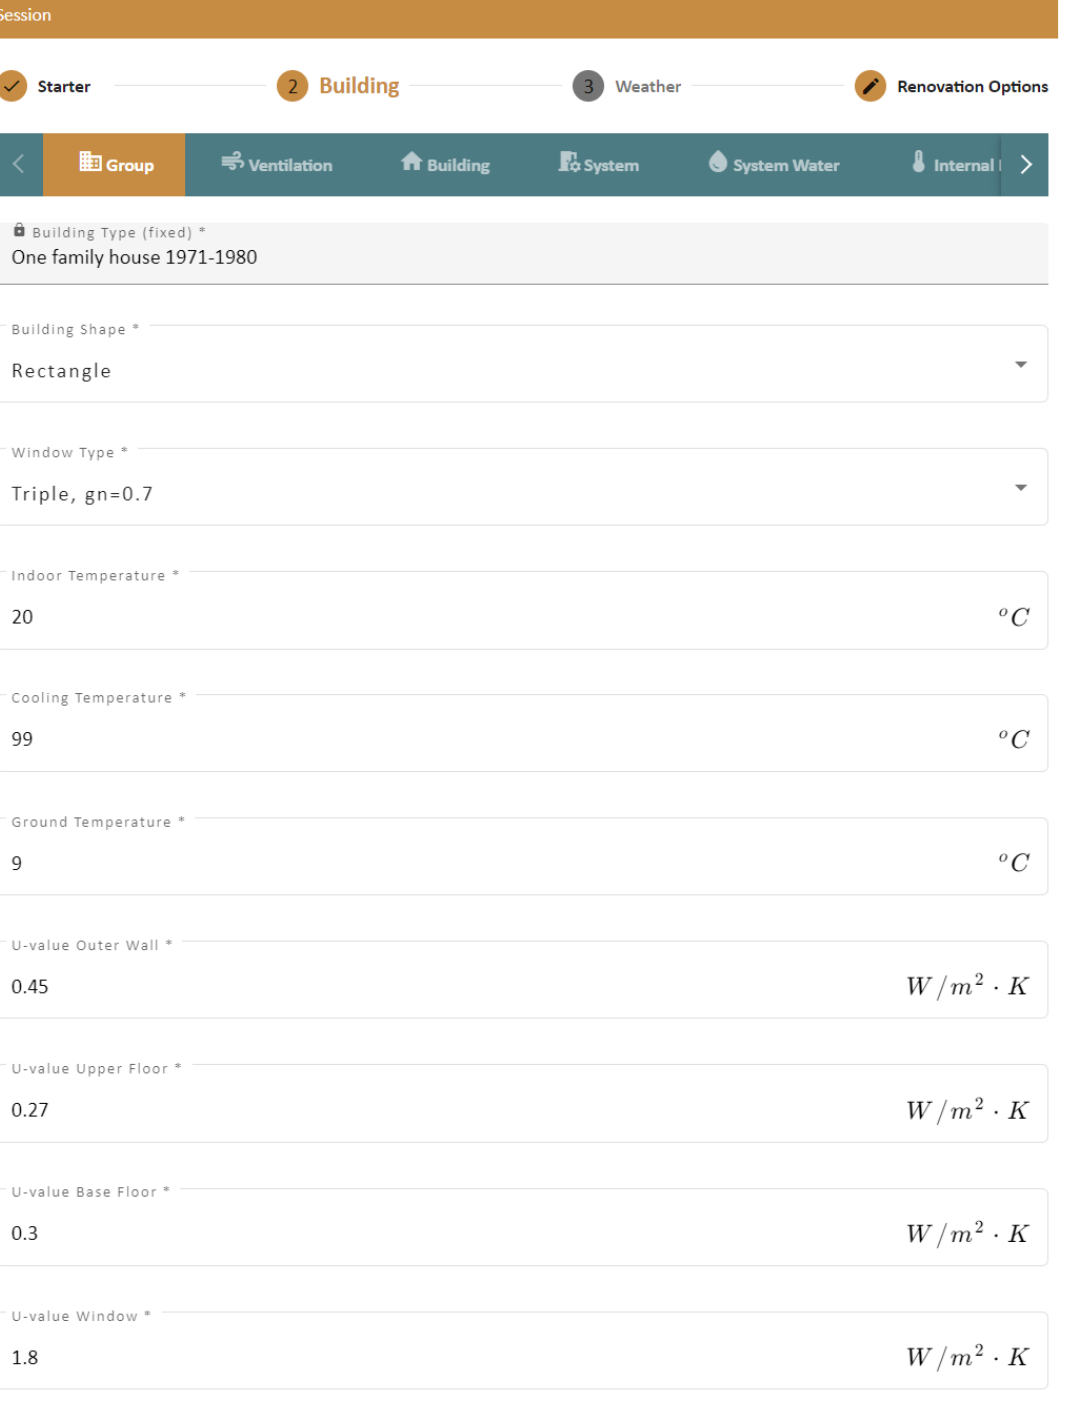
Figure 6. Retrofitting tool GUI: Step 2—Check (and modify) initial values for all building systems. Example of building group parameters.